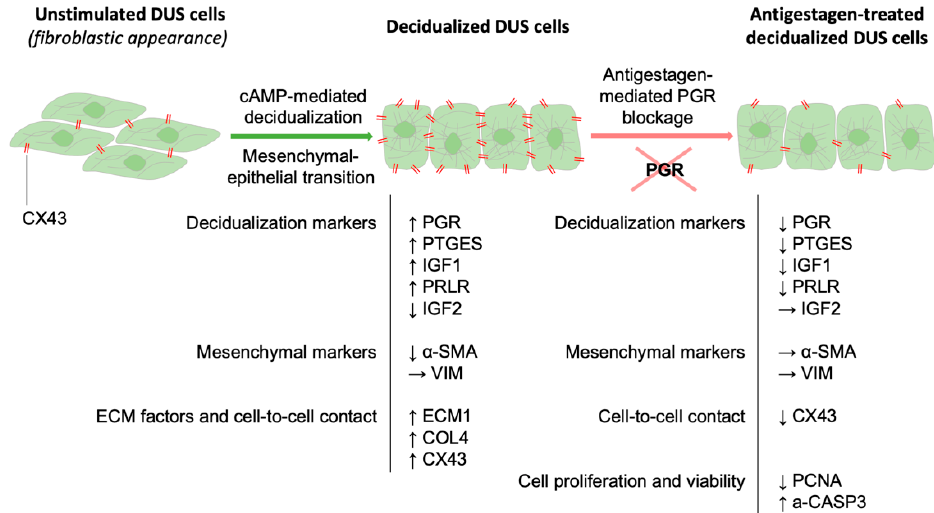
Figure 7. Schematic representation of the changes mediated by in vitro decidualization on DUS cells and the effects mediated by functional blocking of PGR with antigestagens. The main findings of the present study are summarised, with arrows indicating increased ( ↑ ), decreased ( ↓ ) or unaffected ( → ) expression. The fibroblastic appearance of DUS cells changed to a rounded shape after in vitro decidualization, which was unaffected by 6h treatment with antigestagens. Increased expression of decidualization markers, extracellular matrix (ECM) factors and CX43, was observed after cAMP- mediated decidualization. The mesenchymal-epithelial transition of the cells was associated with the cells retaining their mesenchymal character (VIM and α -SMA) and increasing COL4 availability (characteristic of basal lamina). The most important changes after treatment with antigestagens included decreased levels of important decidualization markers and of the gap junction molecule CX43. Additionally, blocking PGR induced antiproliferative and pro-apoptotic effects on decidual- ized DUS cell (PCNA and a-CASP3). The present results highlight the crucial role of P4 signaling in the physiology of decidual cells, further implying its critical role in the termination of canine preg- nancy.